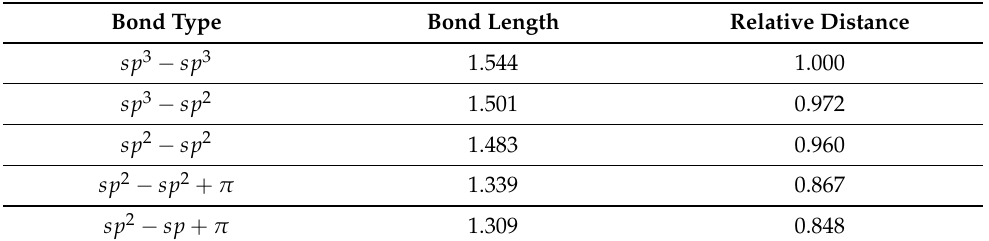
Table 1. Bond types with their lengths and relative